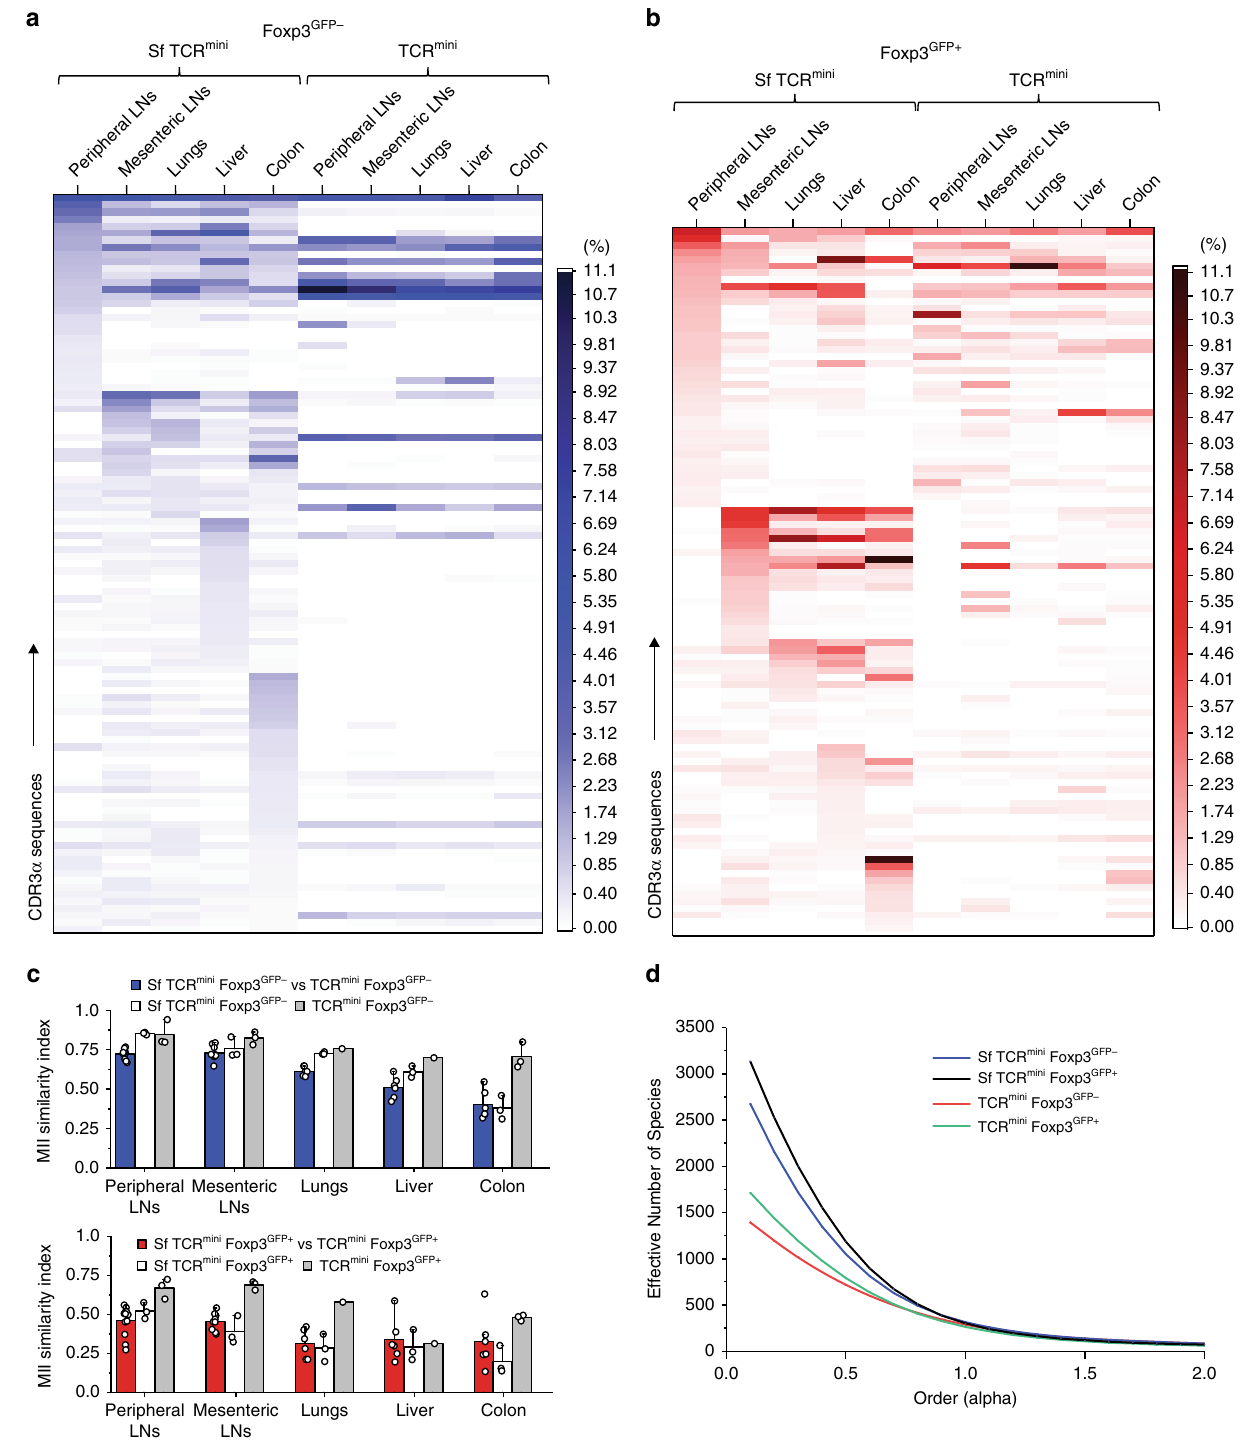
Fig. 2 CD4 + cells from SfTCR mini and TCR mini mice share many αβ TCRs. a Frequencies of 50 dominant TCRs on CD4 + Foxp3 GFP − (blue heatmap) or b Foxp3 GFP + (red heatmap) cells from each indicated organ (sequences see Supplementary Data 1a, b). c Similarity indices (MII) of TCRs expressed by CD4 + Foxp3 GFP − (upper panel) or CD4 + Foxp3 GFP + (lower panel) cells among individual SfTCR mini (white bars) or TCR mini (gray bars) mice or cross- compared among both strains (blue and red bars). d Diversity (REF) calculated for repertoires of CD4 + Foxp3 GFP − (or Foxp3 GFP + ) cells from Sf or control mice. Repertoires from three individual mice from each strain were sequenced. Source data are provided in a Source Data fi le. Error bars depict